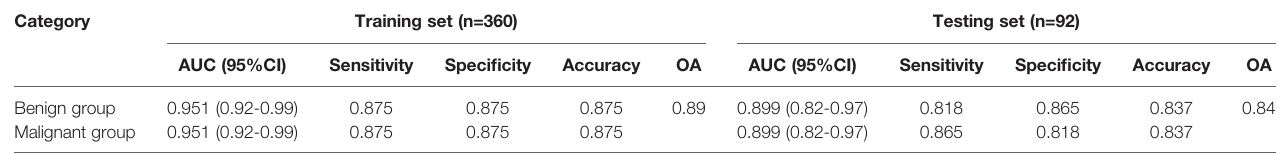
OA, overall accuracy; AUC, area under curve; CI, con fi dence